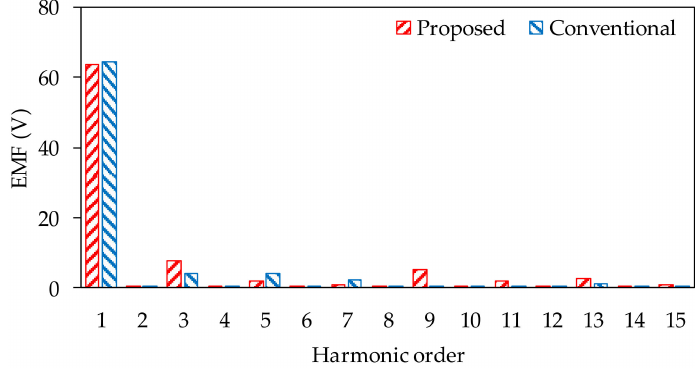
Figure 9. No-load back EMF waves: ( a ) proposed machine; ( b ) conventional machine.